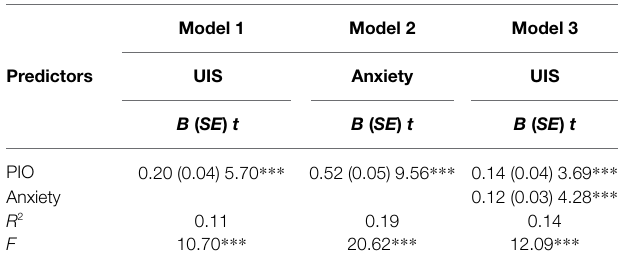
TABLE 3 | Testing the mediating role of